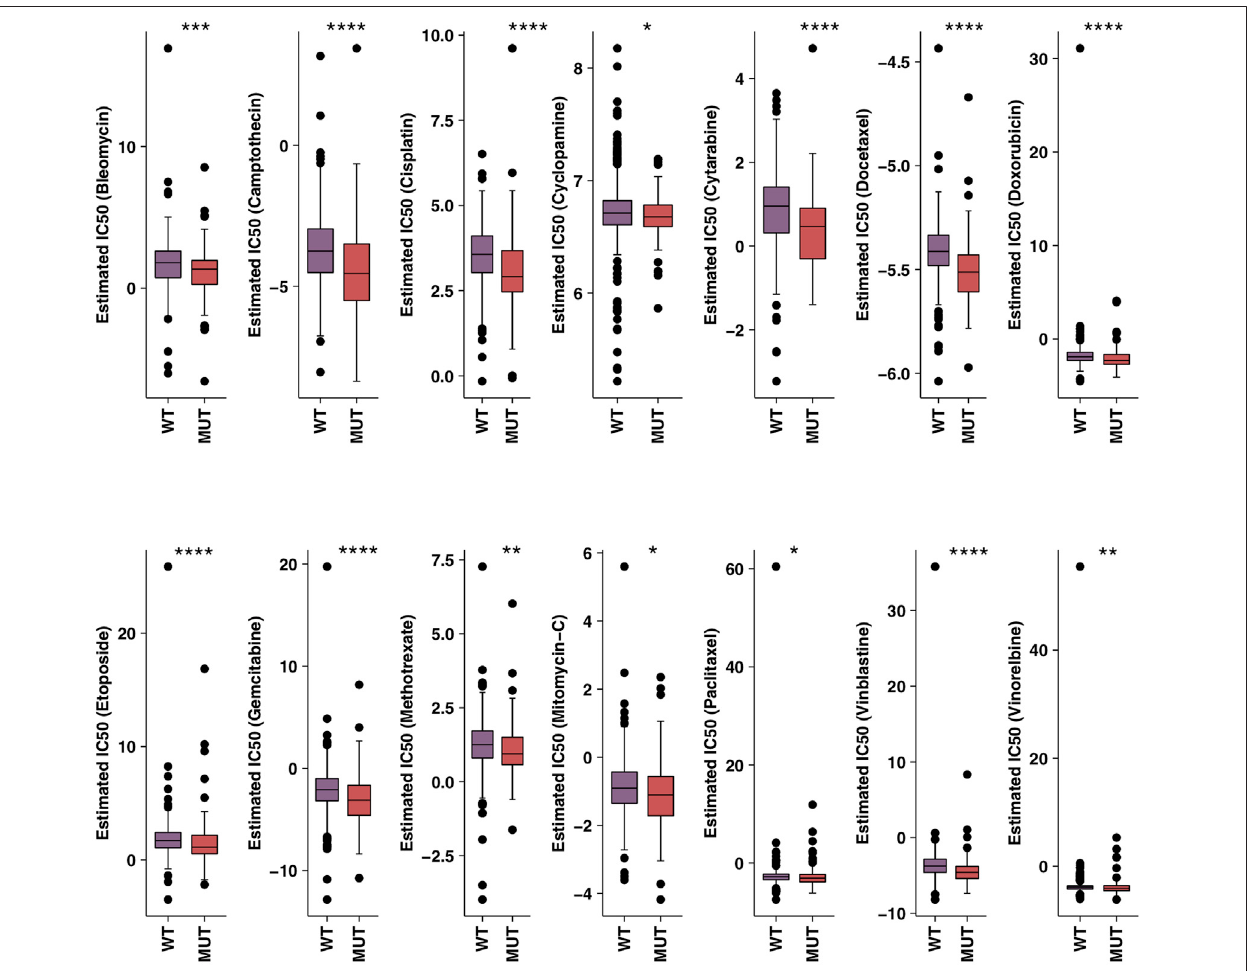
FIGURE3| AcomparisonbetweentheIC50 valuesofcommonchemotherapydrugsusedonHR-MUTandtheHR-WTCRCpatients (* p < 0.05;** p < 0.01;*** p < 0.001; **** p < 0.0001).